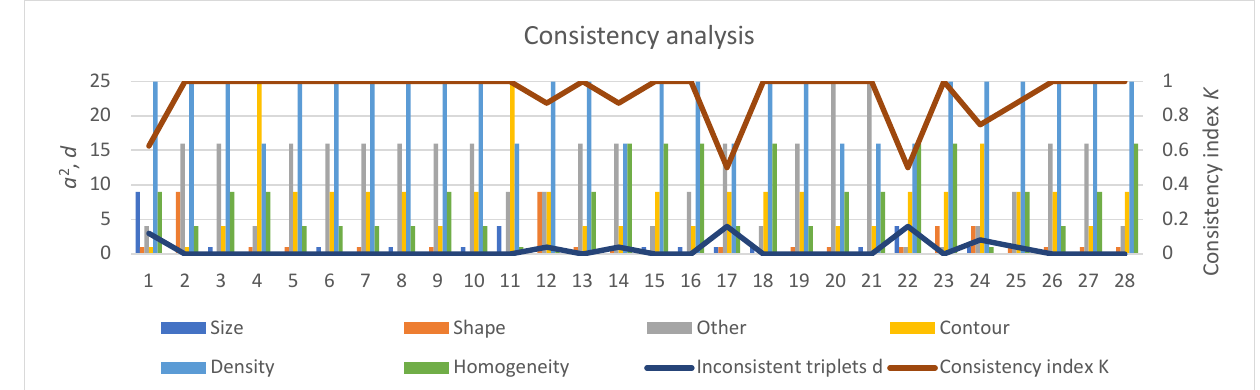
Figure 3. The a 2 results, the number of inconsistent triples, as well as the consistency index derived from the questionnaire for the 28 experts and 6 attributes. The different experts are denoted by numbers 1 to 28 on the horizontal axis, the attributes by the color of the columns, according to the legend at the bottom of the plot. The number of inconsistent triples is shown with a solid dark blue line and the consistency rate is given by a solid dark red line, but the scale corresponding to the consistency index is on the right hand side of the plot.